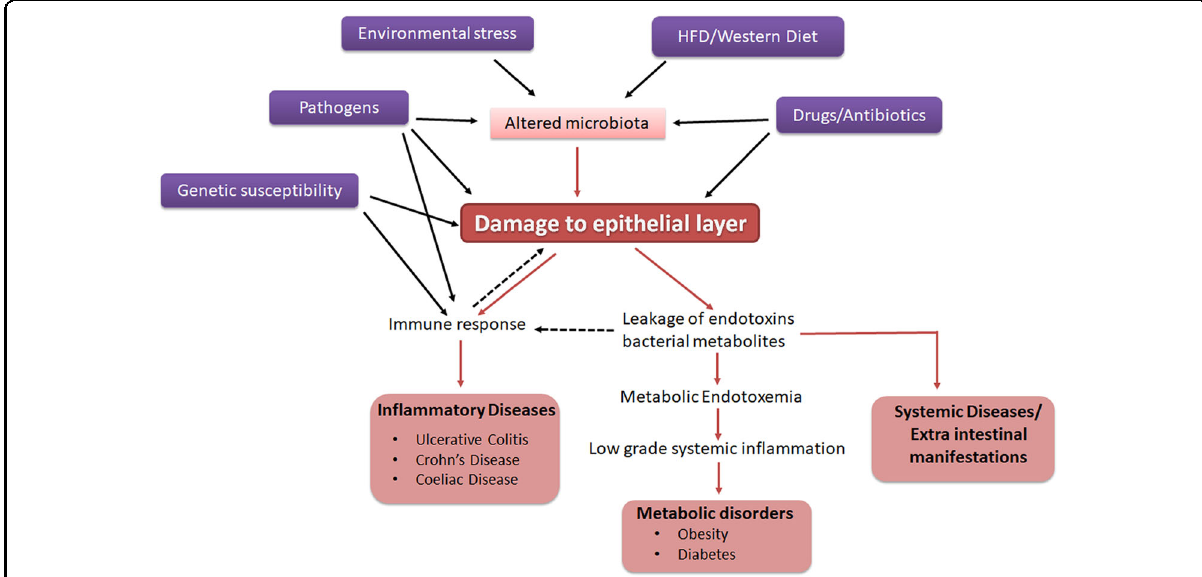
Fig. 2 Factors affecting intestinal barrier integrity and pathological implications. Genetic susceptibility, diet, and a number of environmental conditions affect barrier integrity directly or indirectly through changes in microbiota. Compromised barrier integrity leads to an immune response and contributes to several pathological